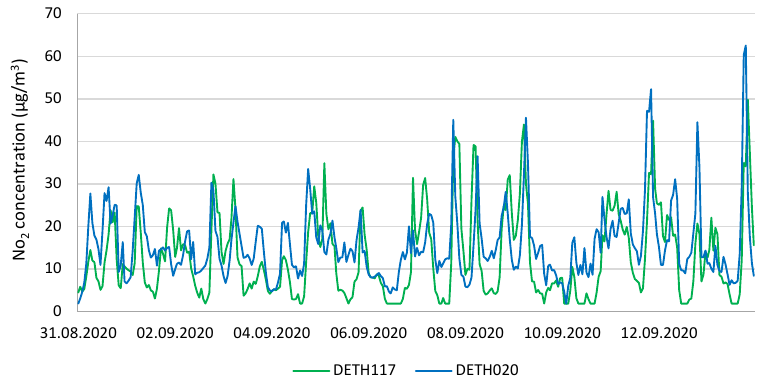
Figure 5. NO 2 concentration for rural sensors, September 2020, first two weeks